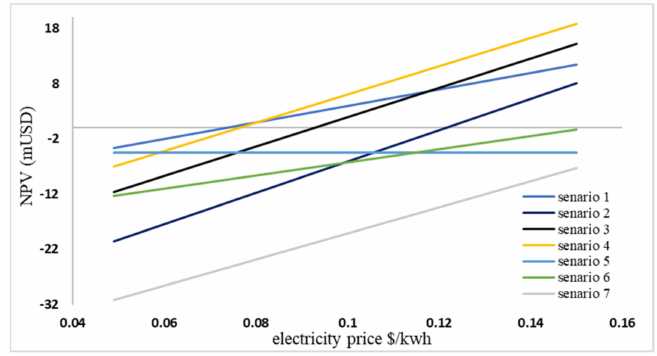
Figure 9. NPV changes based on the selling price of